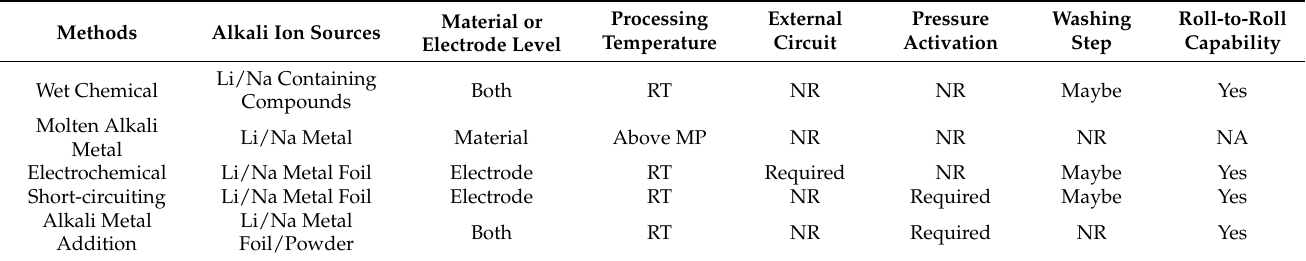
Table 1. Summary of various prelithiation and presodiation techniques and classifications for battery